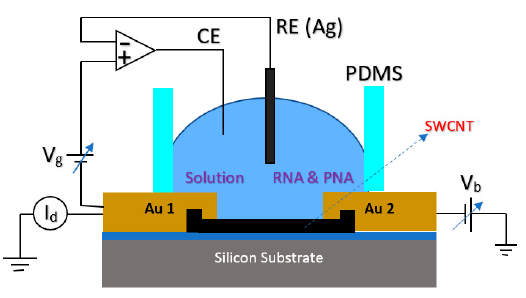
Figure 13. FET structure used for detection of RNA. In the figure, Au 1 and Au 2 demonstrate the source and drain pads, respectively. The gate potential has been applied through the Ag/AgCl as RE, and in this picture, the V b is the bias voltage of the source-drain.